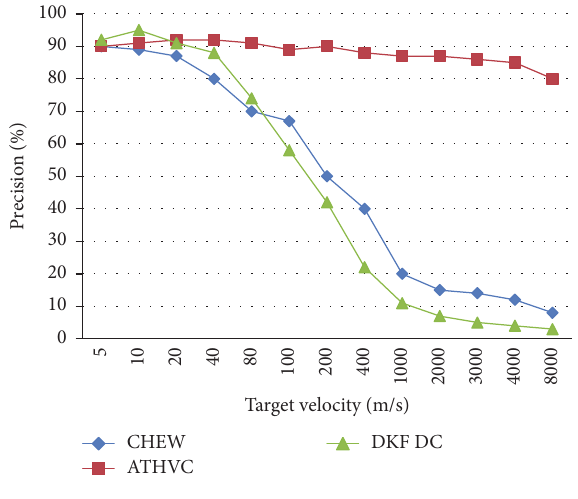
Figure 12: The tracking